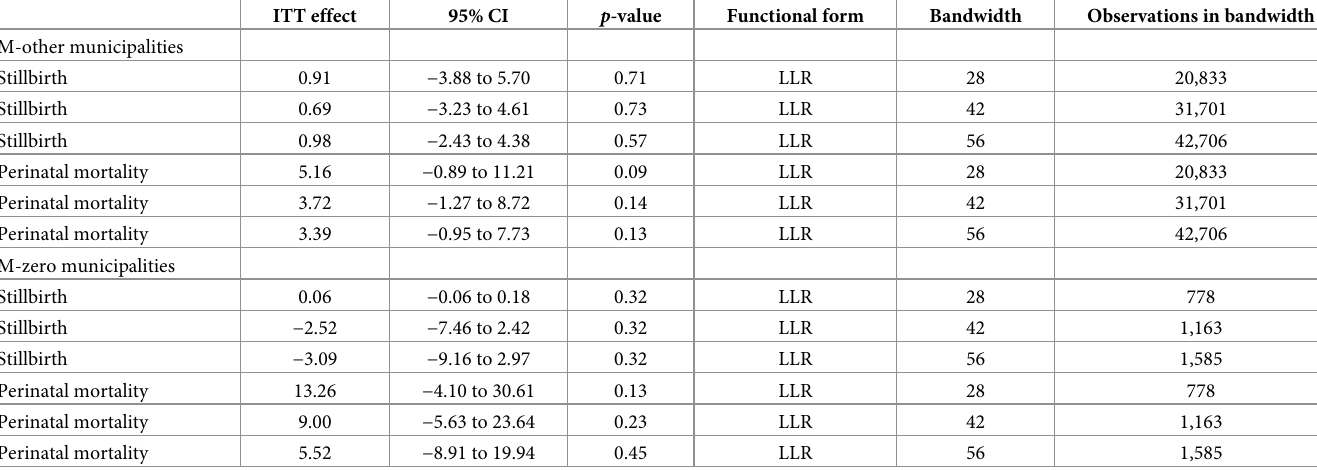
Table 3. Associations between the July 20, 2015 cease-fire and fetal deaths and perinatal mortality. Placebo tests using M-other and M-zero municipalities. ITT effect 95% CI p -value Functional form Bandwidth Observations in